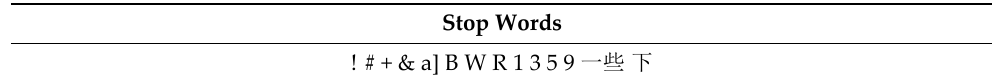
Table 4. Examples of stop words. ( 一些 : some 下 :